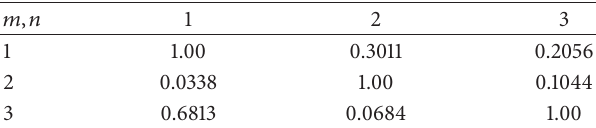
Table 4: Correlation matrix for Small City (lower/upper triangular part: amplitude/phase).